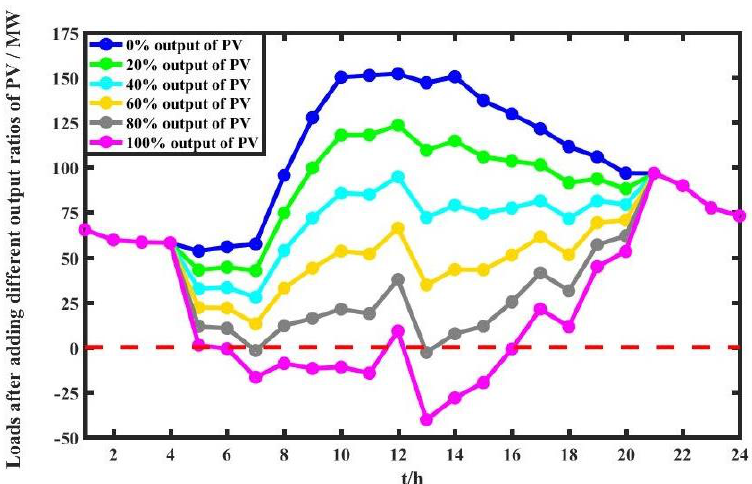
ff erent PV output